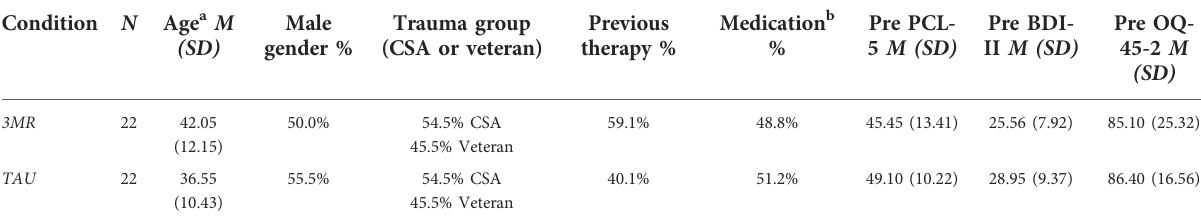
TABLE 1 Descriptive statistics of patients in 3MR and TAU